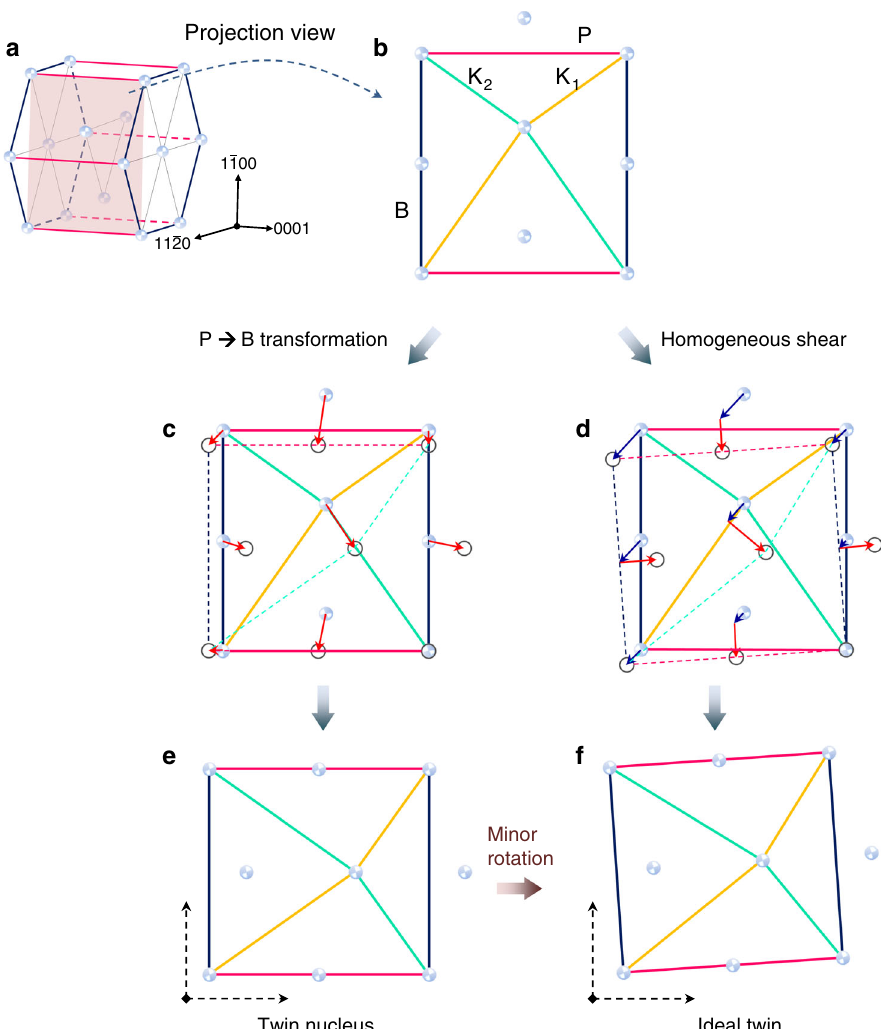
Fig. 3 Schematic illustration of the dual-step twinning nucleation mechanism. a Unit-cell of a HCP structure. Solid balls represent individual atoms. b <1 1 − 2 0 > -projection view of the unit-cell. The prismatic plane (P), basal plane (B), twinning plane (K 1 ), and conjugate twinning plane (K 2 ) are colored magenta, blue, yellow, and turquoise, respectively, for easy tracking of their corresponding planes after the transformations. Arrows in c , d indicate the atomic movements required to accomplish the transformations of the unit-cell; in particular, blue arrows in d indicate the portion that delivers the homogeneous shear. e Twin embryo structure generated by the P → B transformation, which shows a minor rotational deviation compared with the ideal twin f . Angle of the minor rotation can be described by tan − 1 ( s /2), where s is the magnitude of twinning shear (see Supplementary Fig. 2 for the